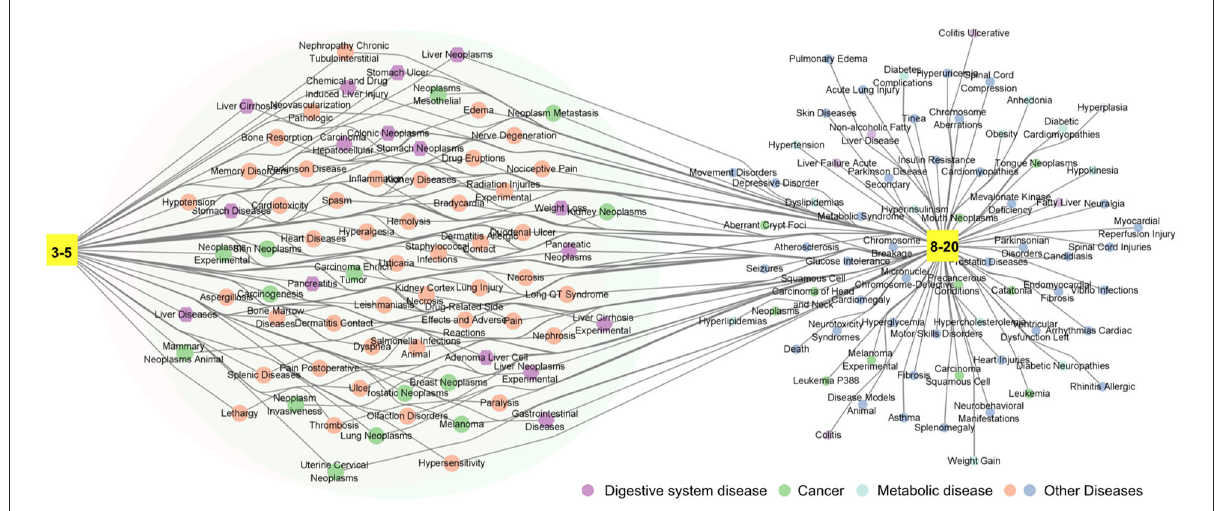
FIGURE6 Network diagram of the medicinal functions of Laoxianghuang. 3–5: third and fifth years of fermentation; 8–20: eighth, tenth, fifteenth, and twentieth years of fermentation; the area covered by two large circles: common medicinal